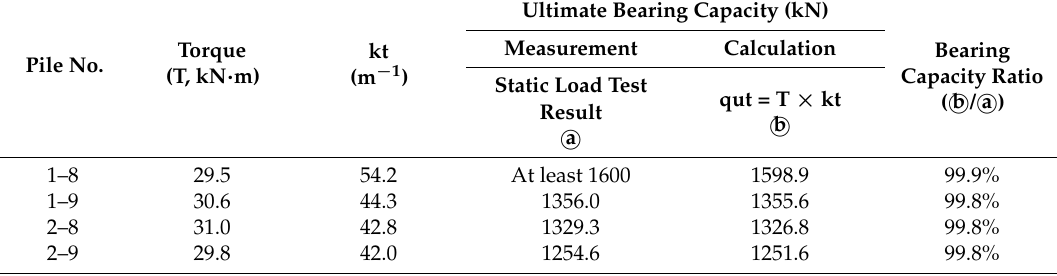
Table 13. T-qu analysis result for grout piles.